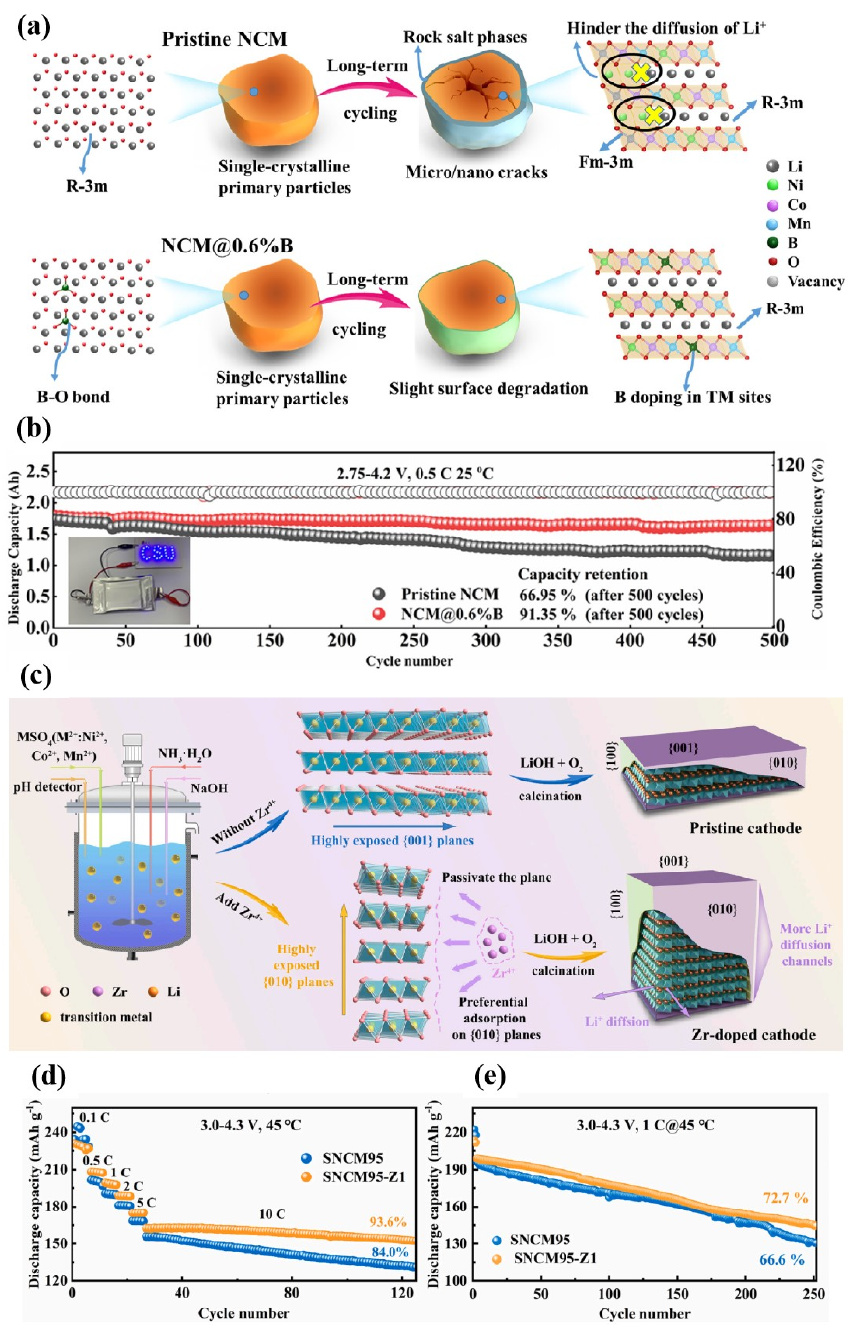
Figure 8. Representative studies of B and Zr doping reproduced from Ref [269] and Ref [272]: ( a ) schematic diagram of the preparation process and cycling performance of NCM@0.6%B; ( b ) the cycling performance of the pouch full cell, Copyright 2021, Elsevier; ( c ) schematic diagram of the preparation process of NCM95 with Zr doping; ( d ) rate capability and ( e ) cycling performance of SNCM95-Z1, Copyright 2023, Elsevier.